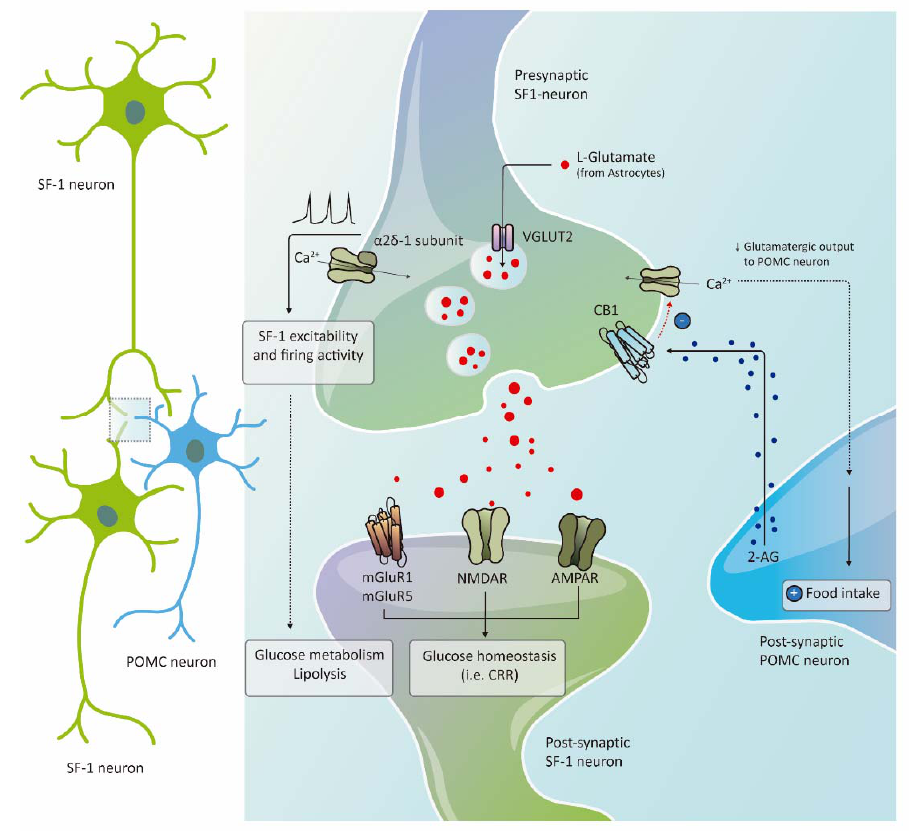
Figure 4. Glutamatergic neurotransmission and synaptic receptors in SF1 neurons and energy balance. Lack of the glutamate vesicular transporter VGLUT2 in SF1 neurons disrupts the glutamate